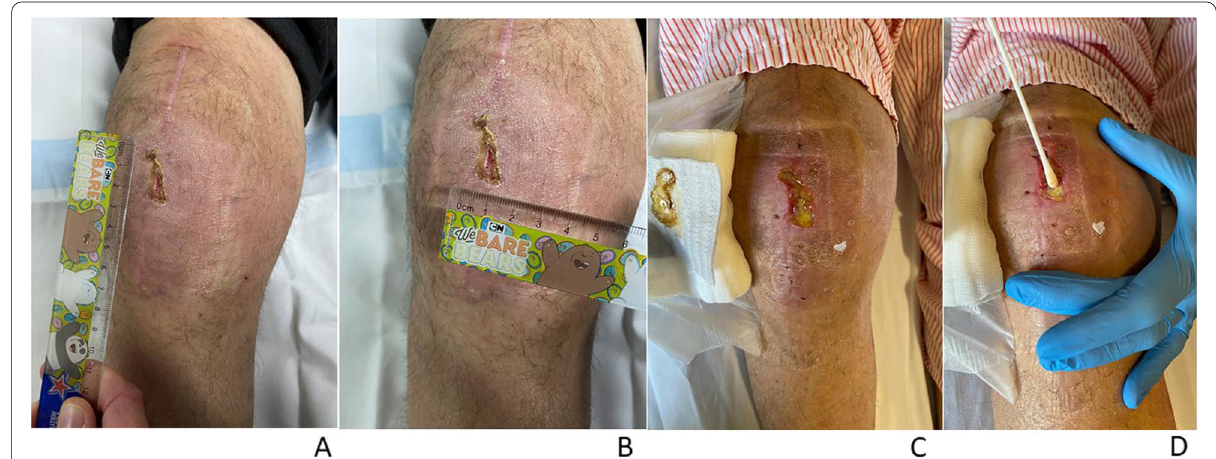
Fig. 1 A persistent approximately 35 18‑mm ulcer on the front of the right knee ( A, B ). The ulcer before the treatment: Appearance when × removing dressing ( C ). Wound cleaning and dressing changes ( D ). After debridement, the al‑PRP was administrated